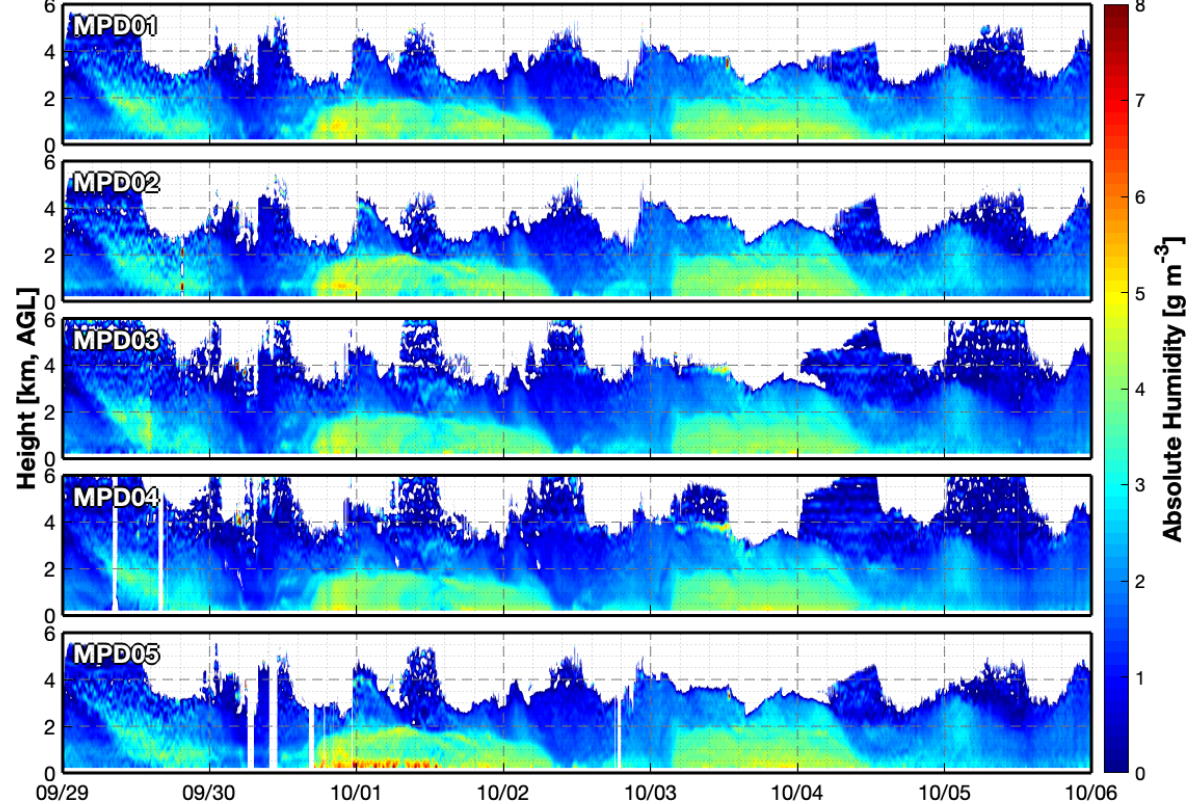
Figure 12. Time series for a comparison test with the Gen 5 MPD units from 29 September to 5 October 2020 in Boulder, CO. Data extend down to 225ma.g.l. Note that from 30 September (23:00UTC) to 1 October (14:00UTC) the WFOV receiver of MPD05 was blocked – a wet bias at the lowest ranges appears during this time. The dropouts in the MPD05 data are due to receiver scans for temperature tests. The pair of dropouts in the MPD04 data are from mode hops of the offline laser. We have found the parameters of the DBR laser can be easily tuned to avoid these conditions should they